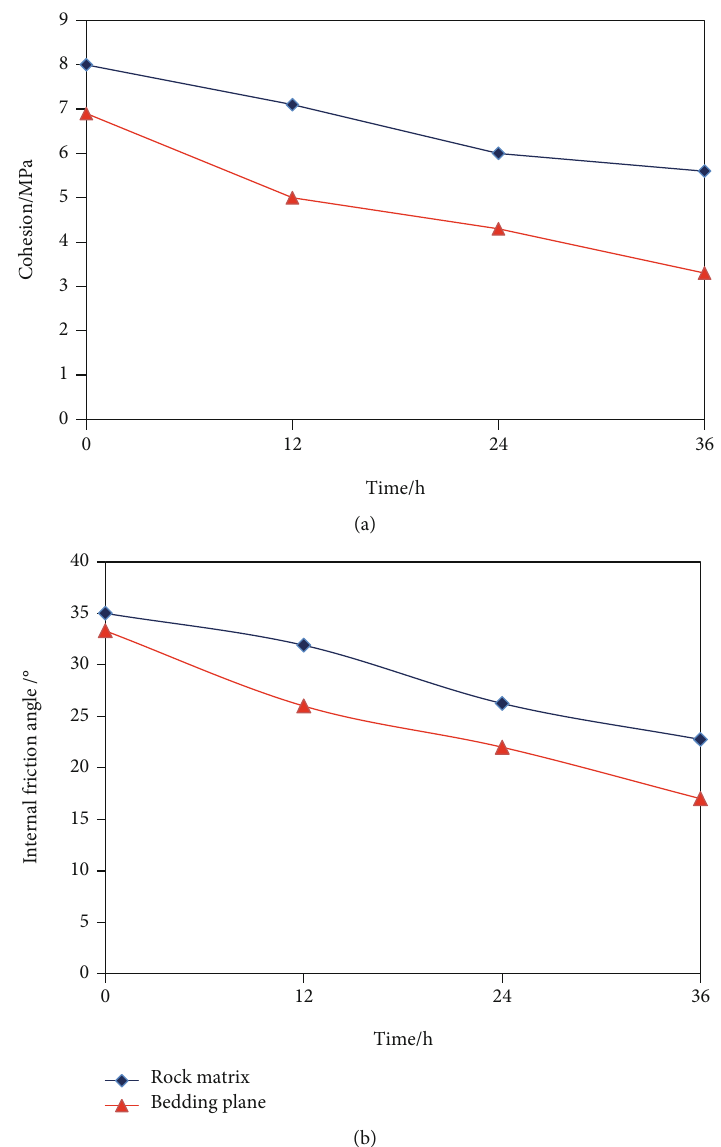
Figure 12: Curve of strength parameter of shale bedding plane and matrix in di ff erent soaking